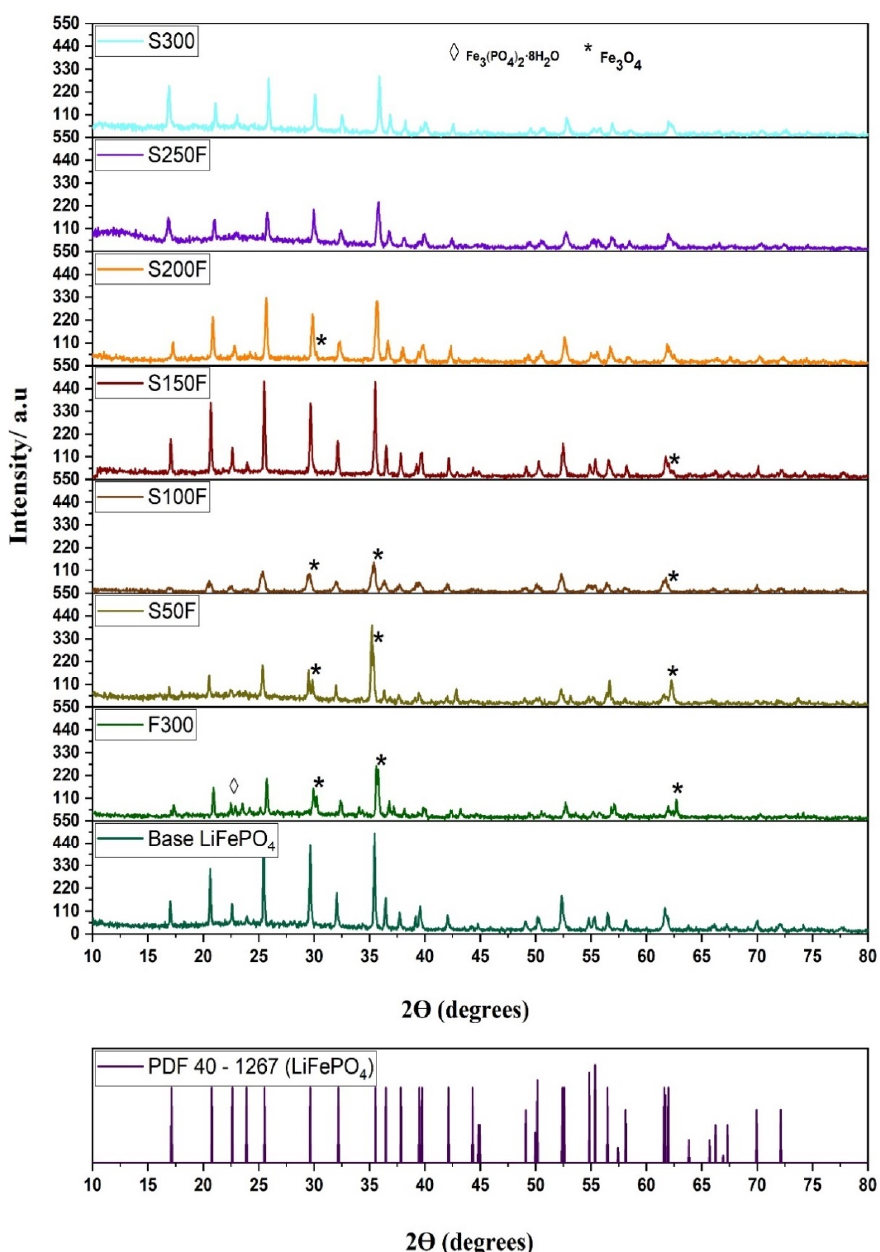
Figure 6. XRD patterns of hydrothermally synthesized LiFePO 4 .